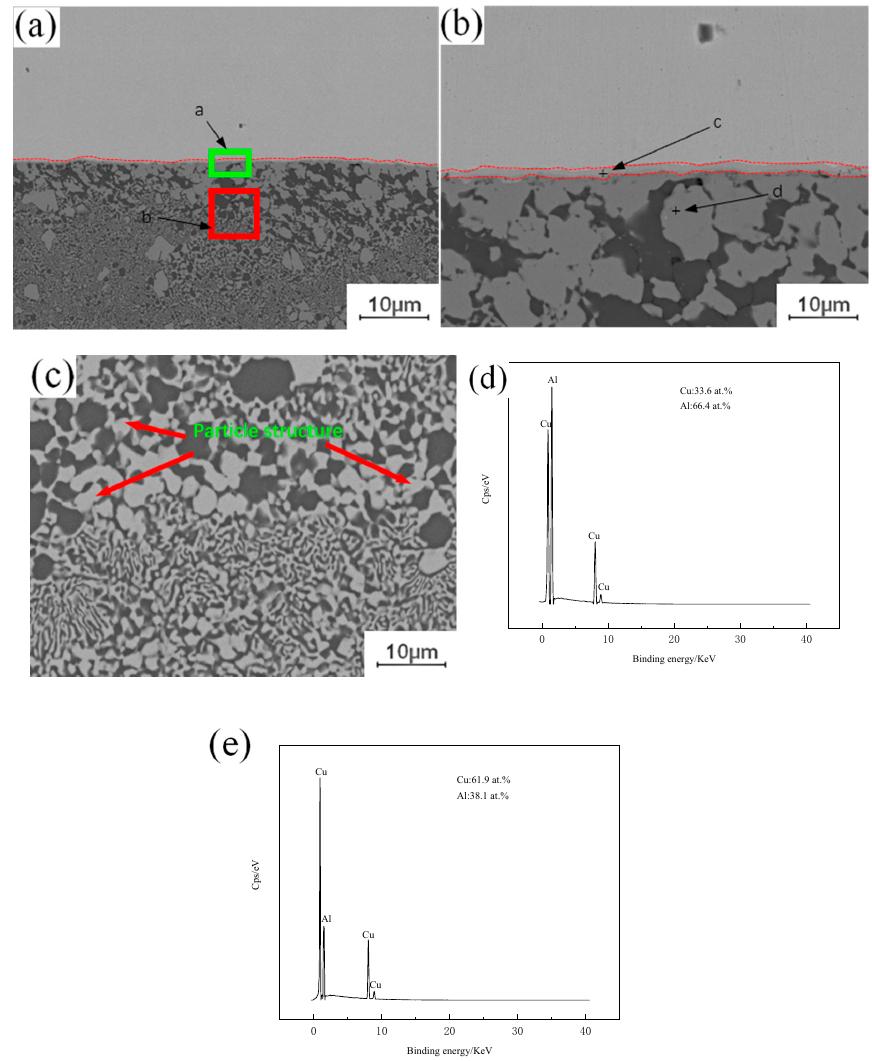
Figure 3. EDS analysis of copper–aluminum lap joint: ( a ) Cu-Al joining interface between copper and aluminum; ( b ) Intermetallic compound (IMC) layer; ( c ) Microstructure of crystal region; ( d ) c point copper and aluminum content; ( e ) d point copper and aluminum